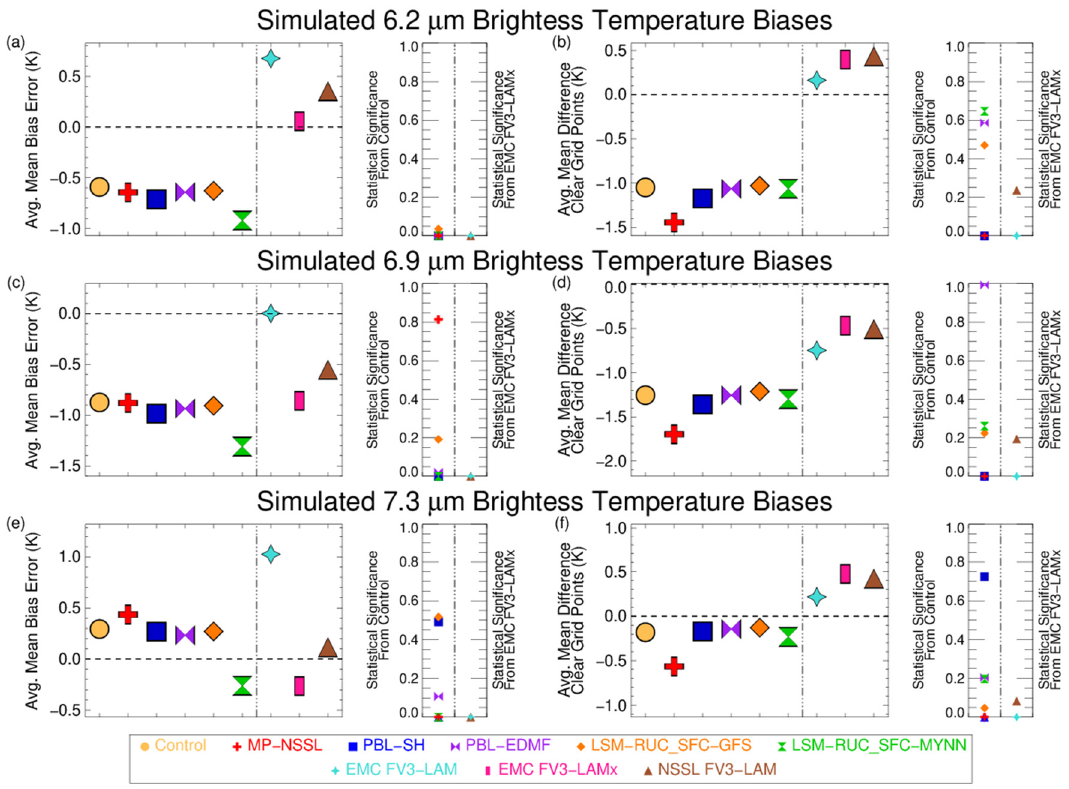
Figure 4. Average mean bias error ( left: a,c,e ) and mean difference for clear grid points ( right: b,d,f ) and statistical significance for 6.2 µ m ( top: a,b ), 6.9 µ m ( middle: c,d ), and 7.3 µ m ( bottom: e,f ) brightness temperatures.